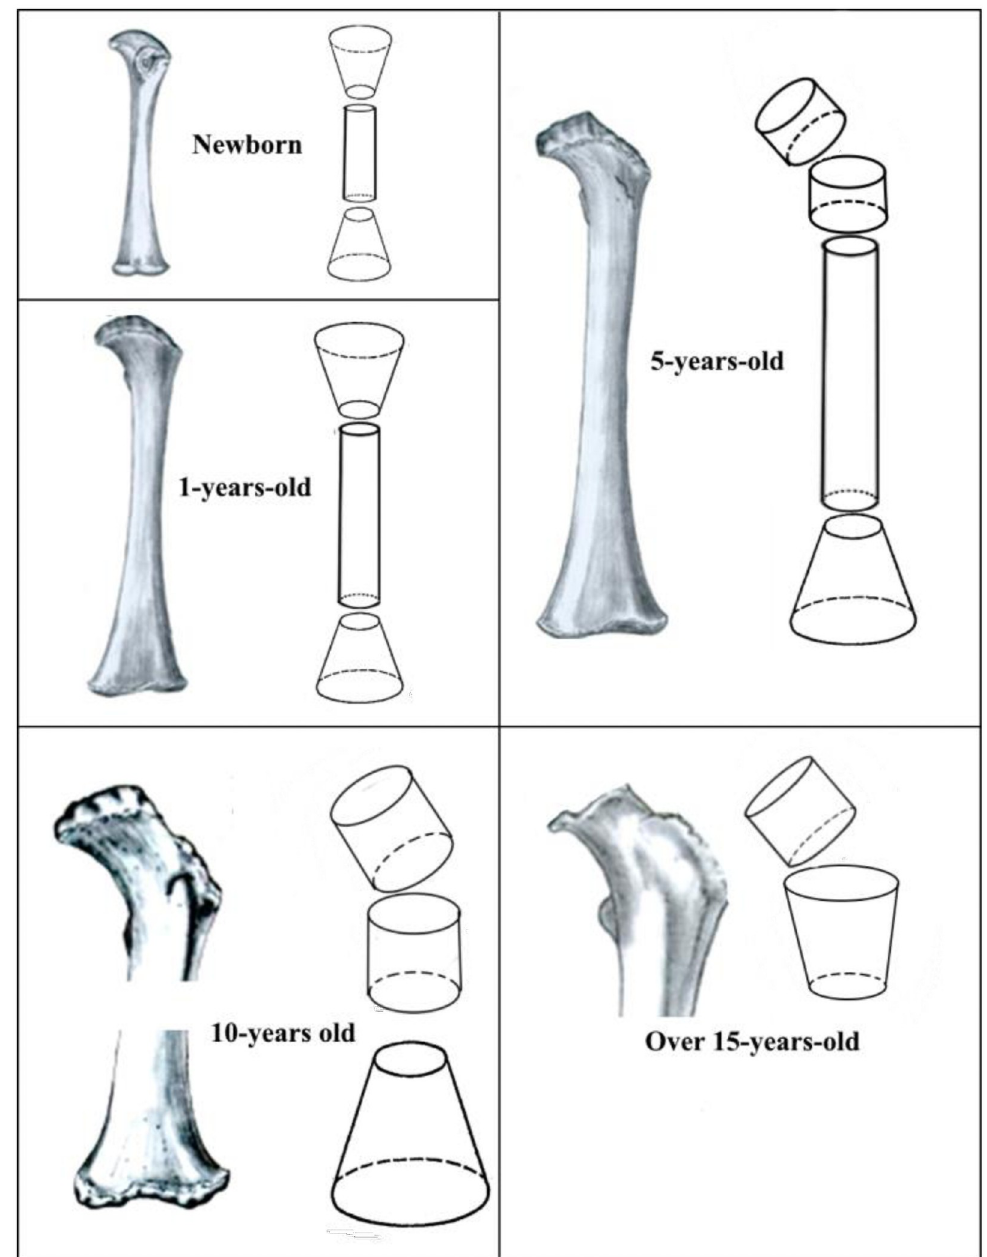
Fig 3. Example of segmentation: Human femur as hematopoietic site at different ages and stylized segments assumed for its description.